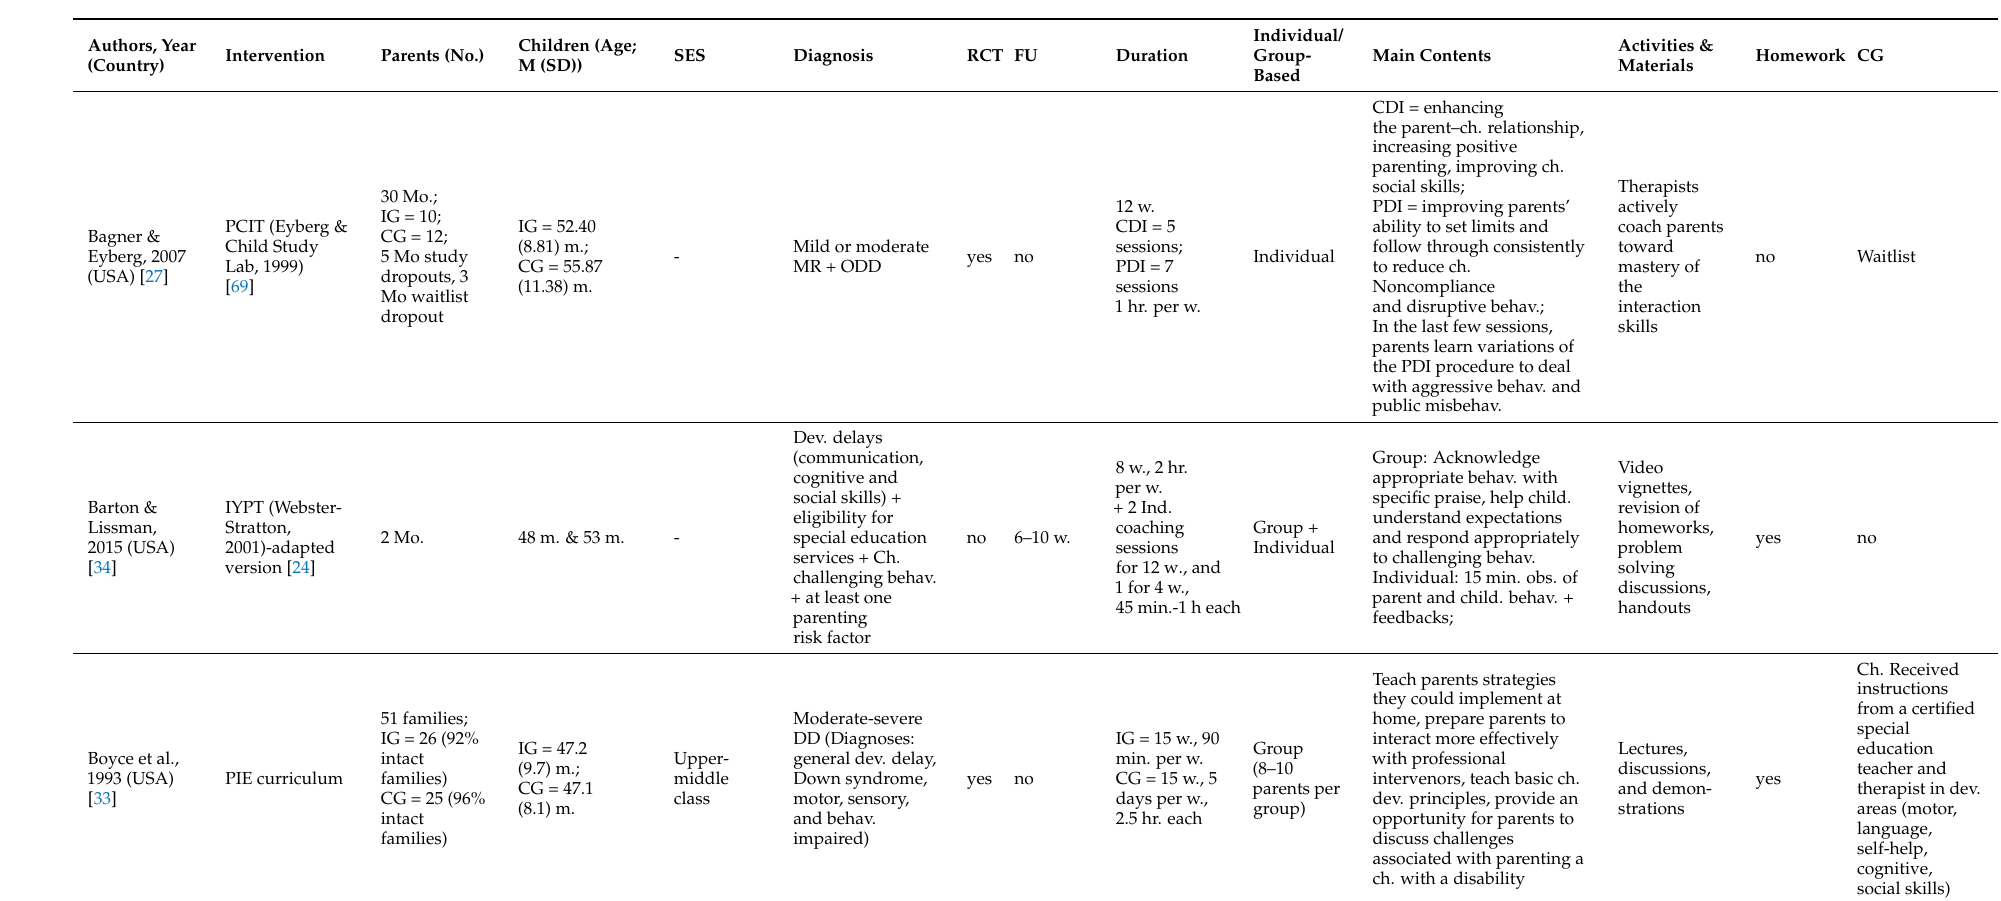
Table A1. Participants and Intervention